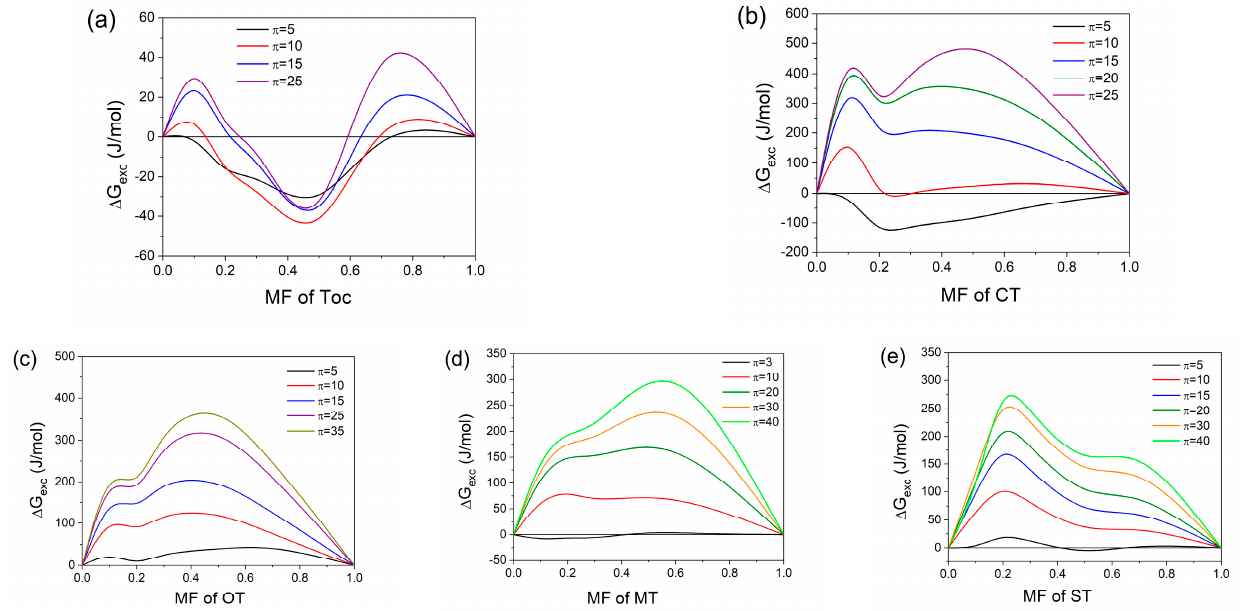
Figure 5. The excess free energy of mixing ∆ G exc versus mole fraction of ( a ) Toc, ( b ) CT, ( c ) OT, ( d ) MT, and ( e ) ST as a function of monolayer composition at different surface pressure (mN/m), as shown in legend.